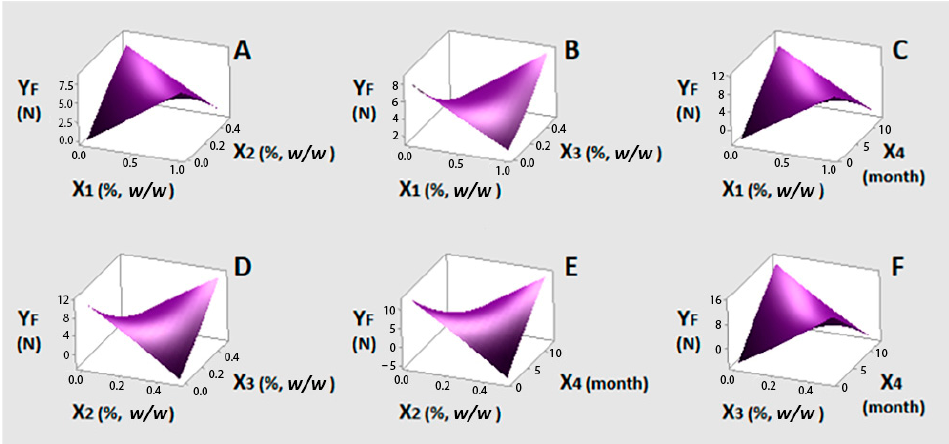
Figure 5. ( A – F ) three-dimensional surface plots for firmness (Y F , N) as a function of oregano (X 1 %, w/w ), lemon balm (X 2 %, w/w ), bay laurel (X 3 %, w/w ) EOs contents and time (X 4 , month). In all cases, the rest factors were kept constant at their middle levels (0.5%, 0.25% and 0.25% w/w and seven months, respectively).